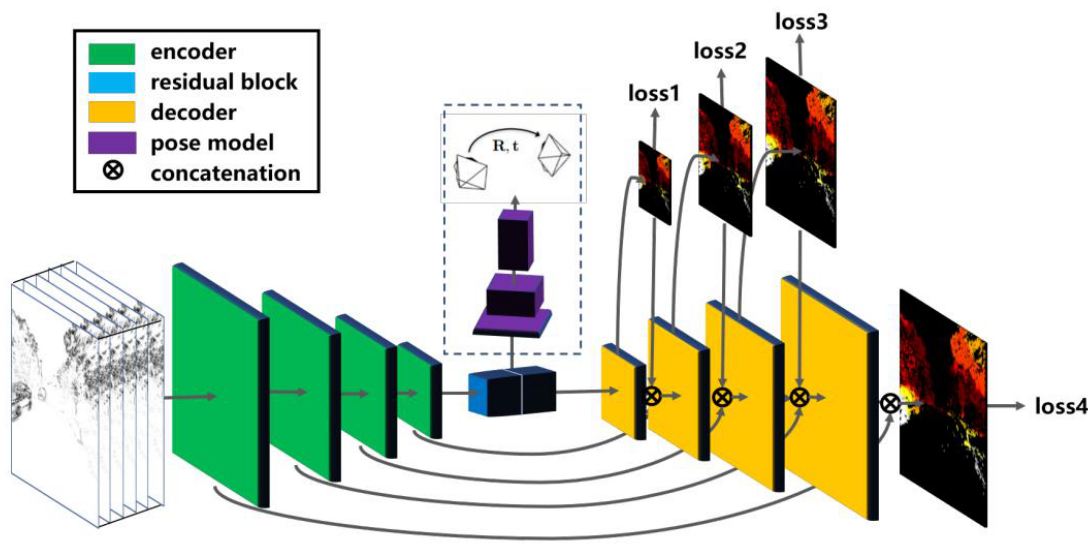
Figure 9. Network architecture for both the optical flow and egomotion and depth networks. This figure has been taken from [95]. figure has been taken from